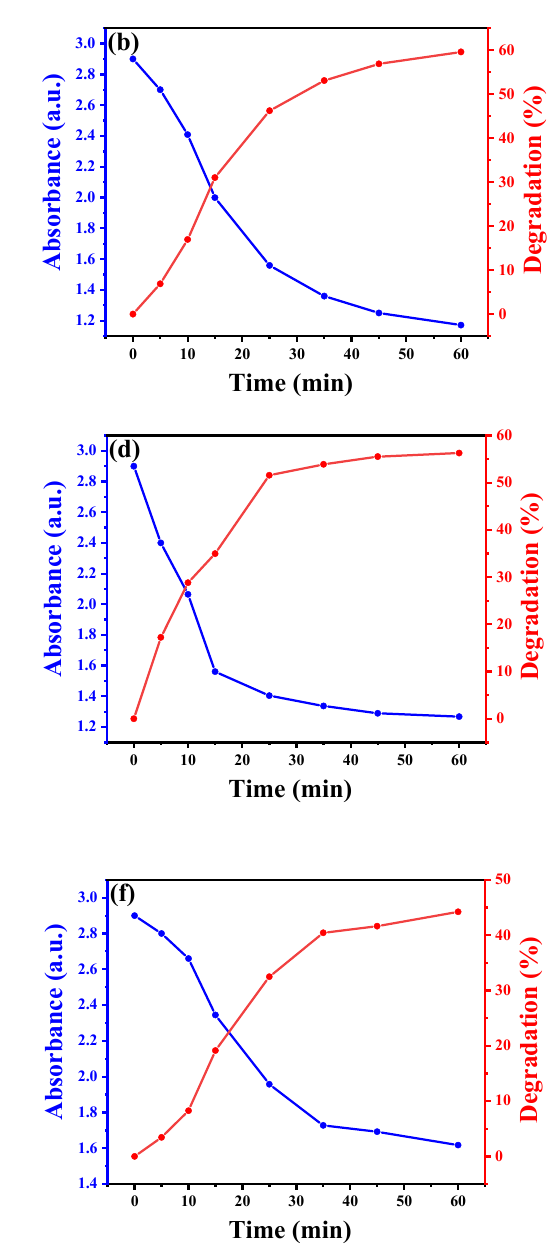
Figure 6. The time influence reaction of ZnONPs on the degradation of MB dye: ( a ) shrimp shells , ( c ) crab shells , ( e ) Streptomyces griseus bacteria . Degradation percent of MB dye ( b ) ZnO NPs by shrimp shells , ( d ) ZnO NPs by crab shells , and ( f ) ZnO NPs by Streptomyces griseus bacteria . According to Equations (3)–(9), the photoexcitation, charge separation and migra- tion, and finally, oxidation-reduction reactions at the surface, the reactive species formed during the irradiation of ZnO NPs are (VB), h + , O 2 − , and OH [38]. The ZnO NPs are ex- posed to solar radiation (Figure 7), which causes electrons to move from VB to CB. The resulting energy is larger than the band gap of ZnO (2.37, 2.87, 3.21 eV), which promotes the formation of conduction band electrons (e) and valence band holes (h + ). The photo- generated holes on the VB could either directly oxidize the adsorbed MB dye or directly react with hydroxyl (OH ˙ ). Meanwhile, oxygen (O 2 ) adsorbed on the surface of ZnO NPs can be converted into superoxide radicals (O 2 ) by photoelectrons at the CB. For this reason, both OH ˙ and the generated O 2 can photocatalytically degrade the MB dye [39,40].